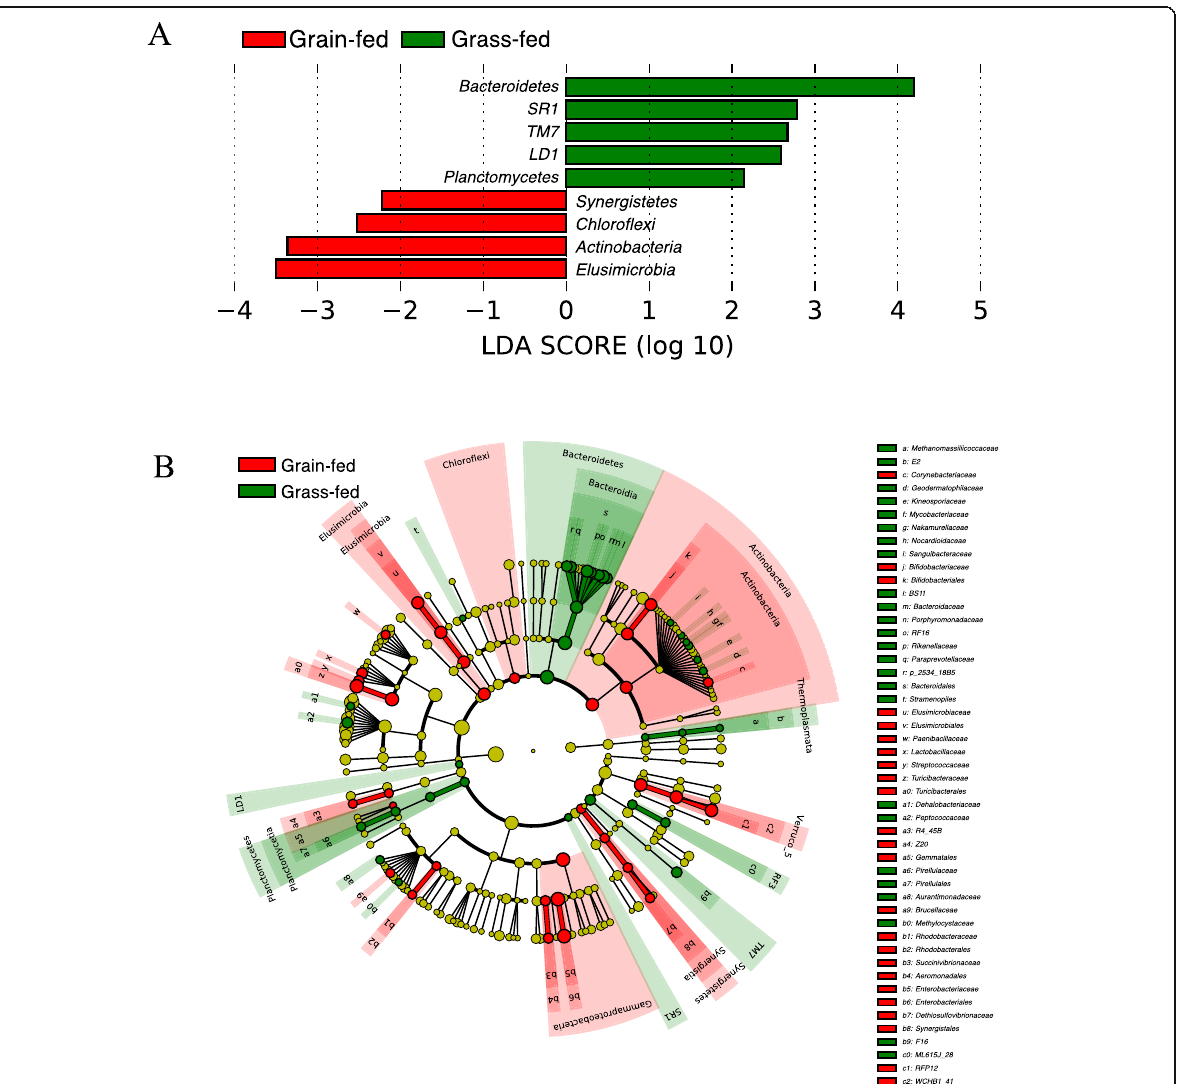
Fig. 5 a Significantly discriminative phyla with LDA score ≥ 2.0 in jejunal bacterial communities between grain-fed and grass-fed cattle. b A cladogram representing the significant families in the jejunal bacterial communities. Only those taxa that had significant differences in relative abundance between grass-fed and grain-fed cattle with an absolute LDA score ≥ 2.0 were